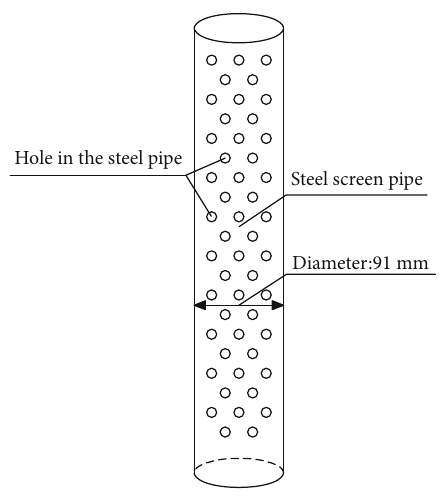
Figure 7: Illustration of the steel screen